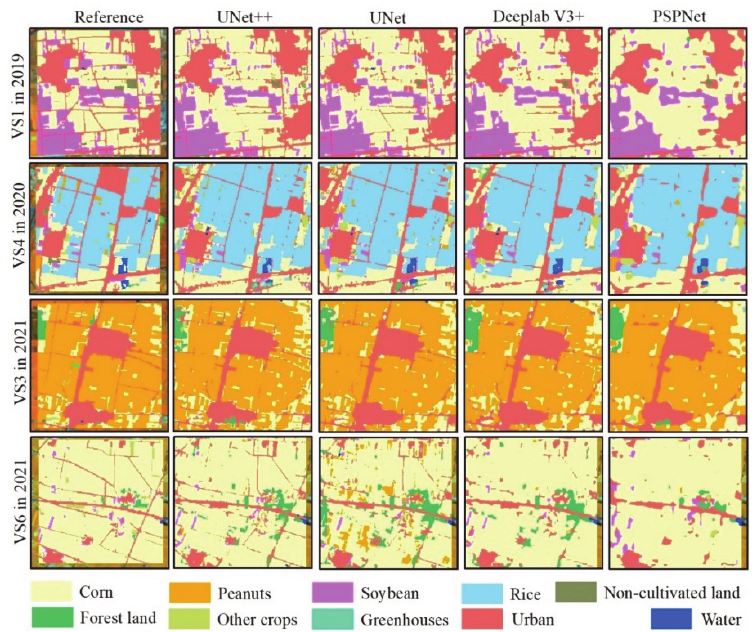
Figure 7. Validation sample plots and local ‐ scale prediction classification results of Scheme 2 in 2019, 2020, and 2021. 2020, and